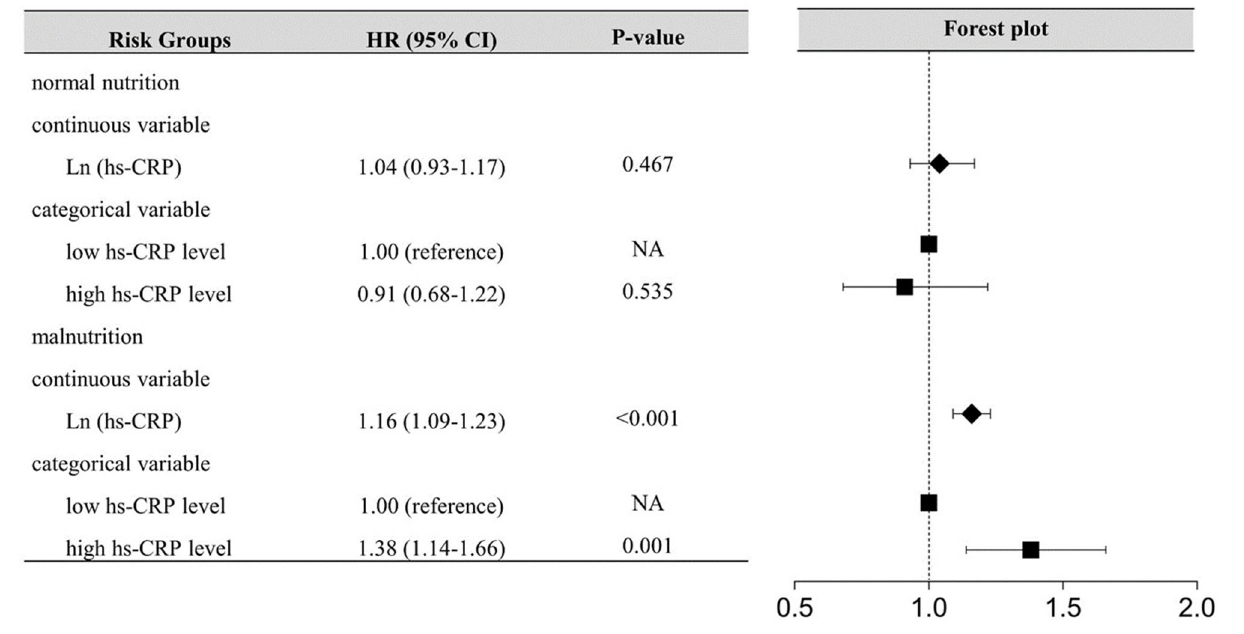
Frontiers in Nutrition |